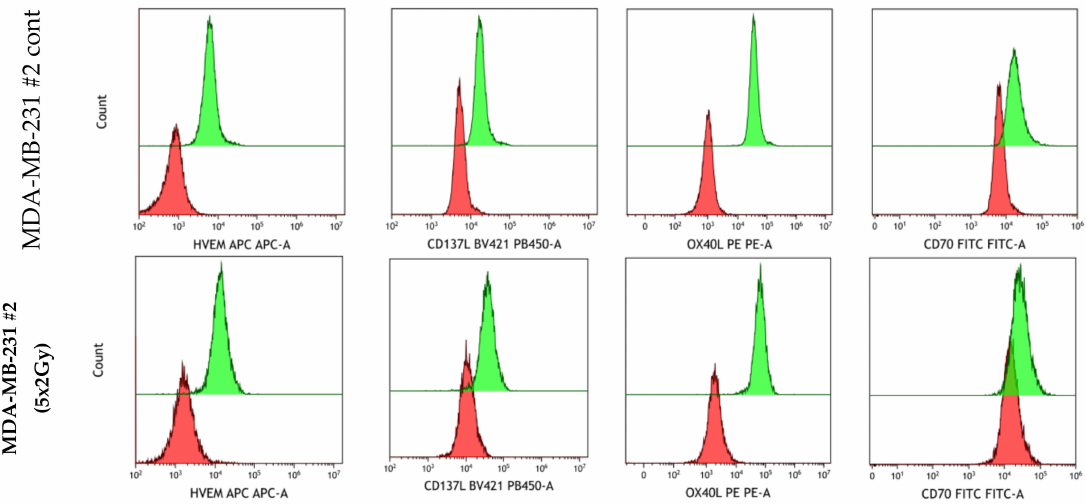
Figure A3. Fluorescence intensity (FI) peak of each fluorochrome of Panel#2 for untreated (cont., d5) and irradiated (5 × 2 Gy, d5) MDA-MB-231